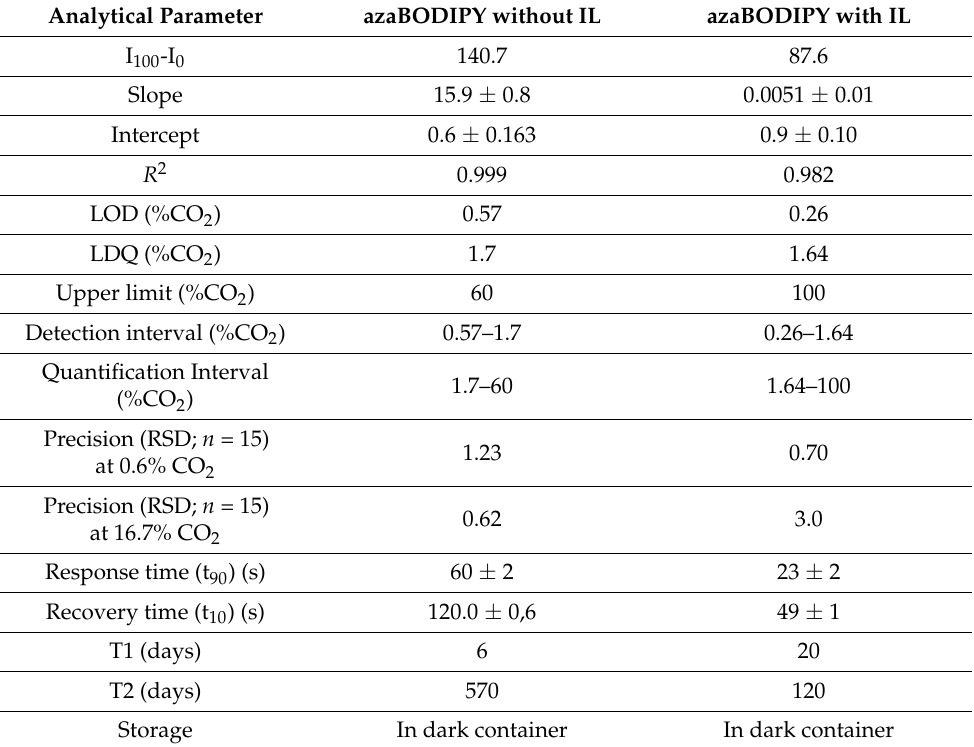
Table 2. Comparison of the analytical characteristics of sensing membranes for CO 2 determination with and without